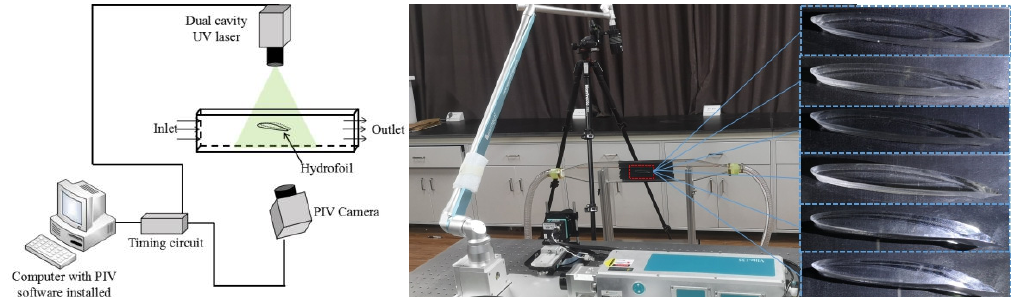
Figure 4. PIV experimental equipment.